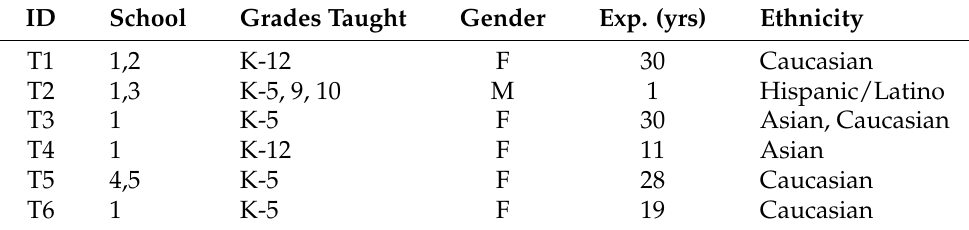
Table 1. Demographics of English language learner teacher sample ( n =